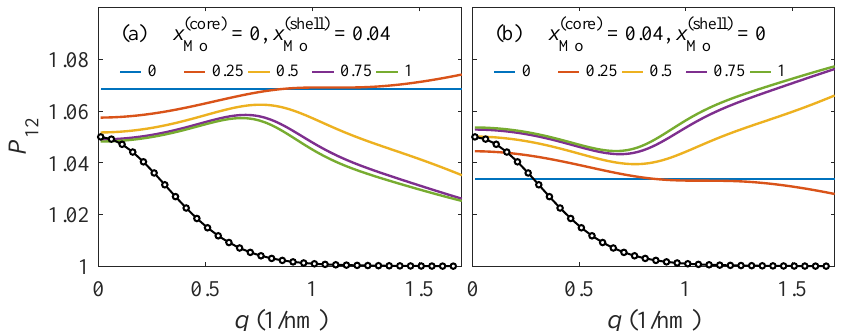
Figure 6. Ratio of integrated intensities P 12 ( q ) calculated for Mo atoms present in the shell ( a ) and in the core ( b ), and various parameters p (parameter of the curves). The black line with dots displays the q -dependence of the diffracted intensity; the vertical axis for this curve is not in scale.